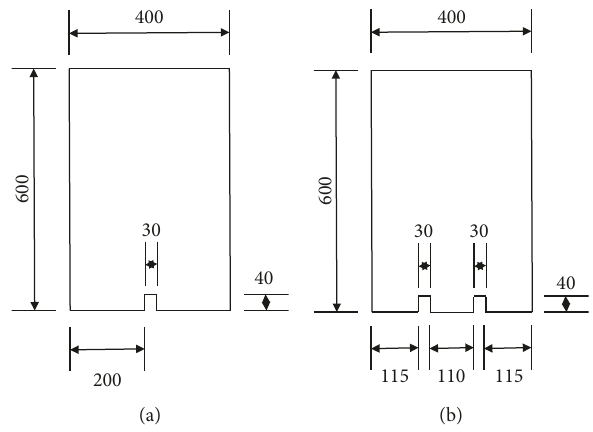
Figure 12: Dimensions of grooves (in mm). (a) One line. (b) Two